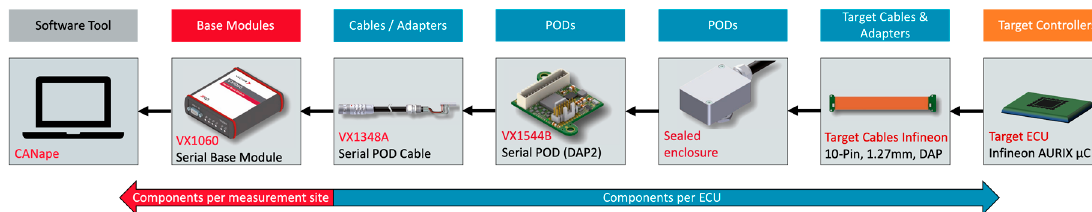
Figure 8. Simplified connection and data flow overview of the ECU measurement tool chain [24]. The information of the measured values is read out from the target ECU (AURIX µ C) and sent via a specific adapter that is suitable for the µ C to a serial POD. The POD itself is connected by a serial cable with the base module. Using a dedicated software tool ( CANape ), the information measured by the ECU can be captured and processed for further investigations.